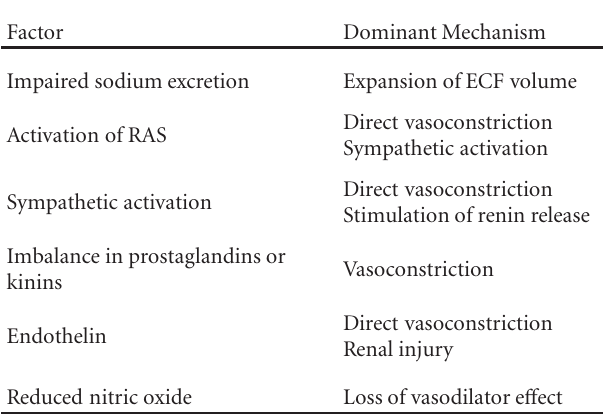
Table 1: Selected factors that may cause hypertension in chronic kidney disease ∗